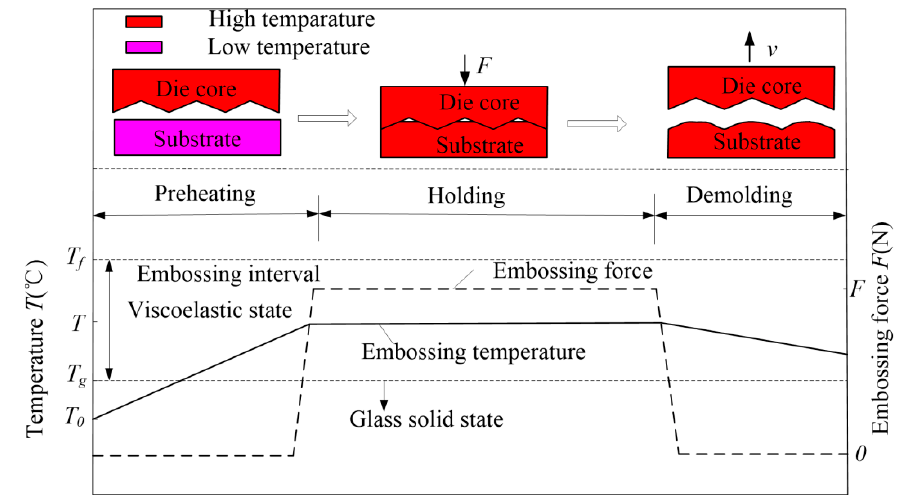
Figure 4. History of hot-embossing glass-microprism array.